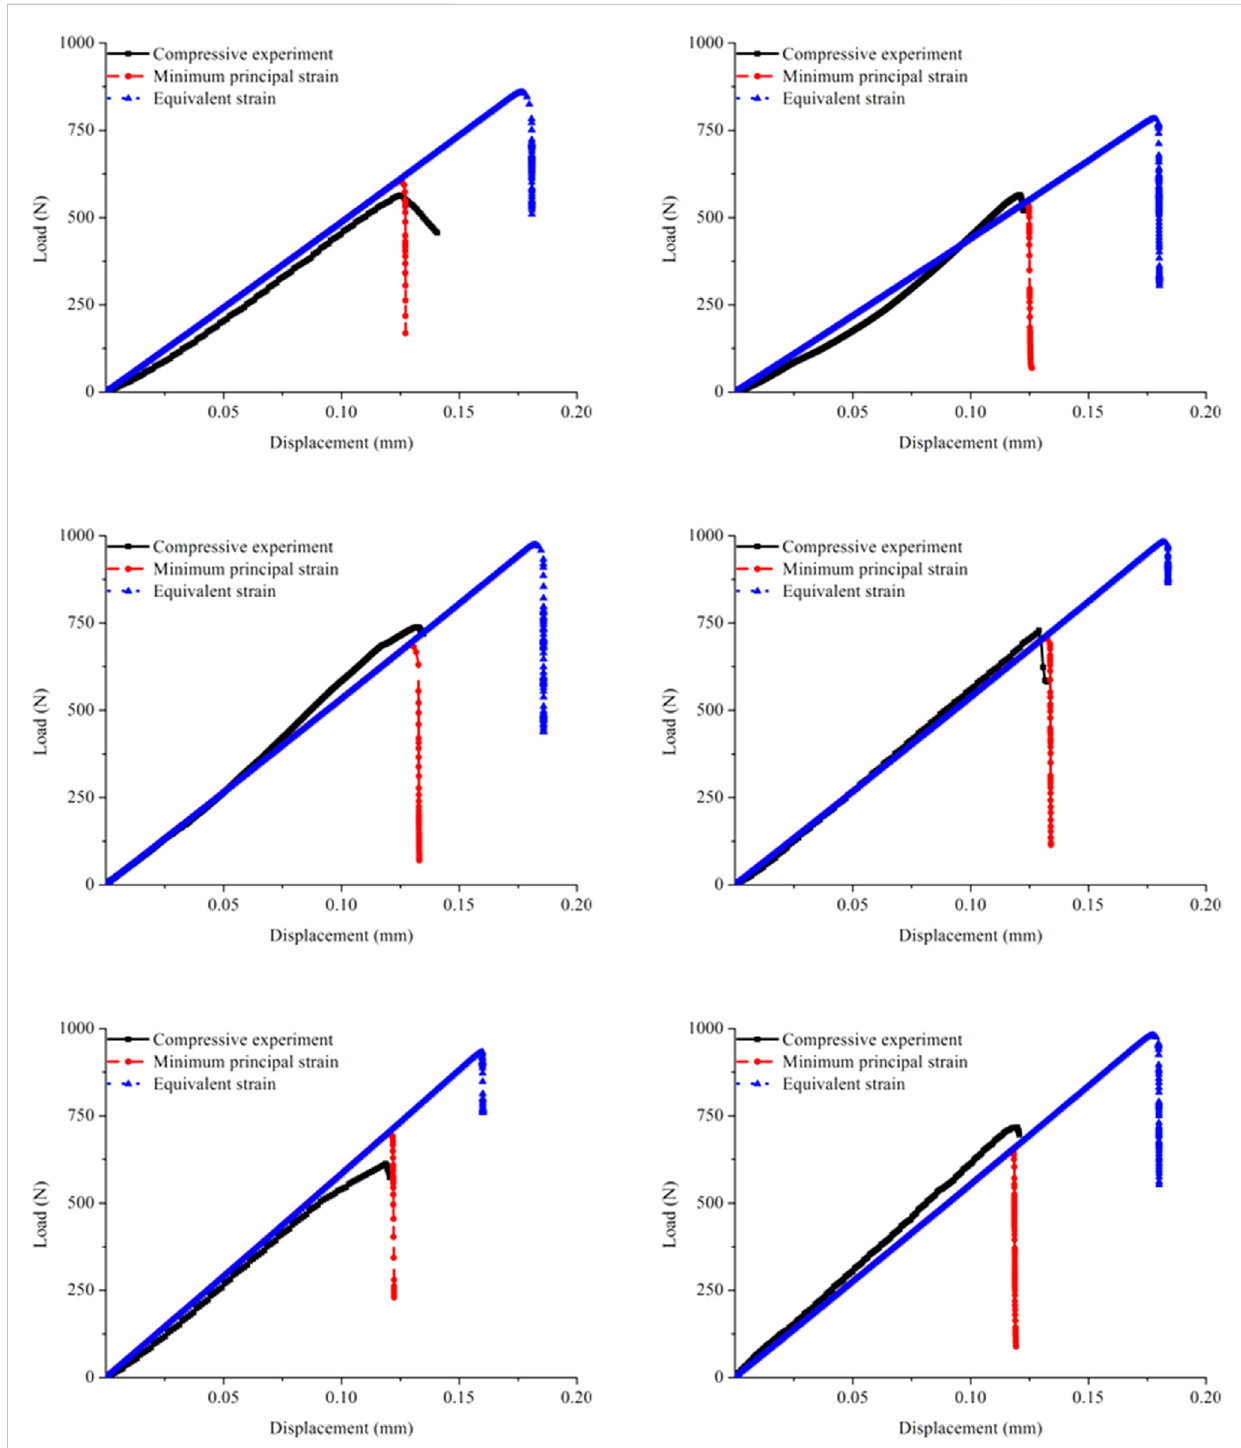
Comparison of the load – displacement curves in the six specimens and corresponding FE models obtained from the experiments and simulations separately using the minimum principal strain and equivalent